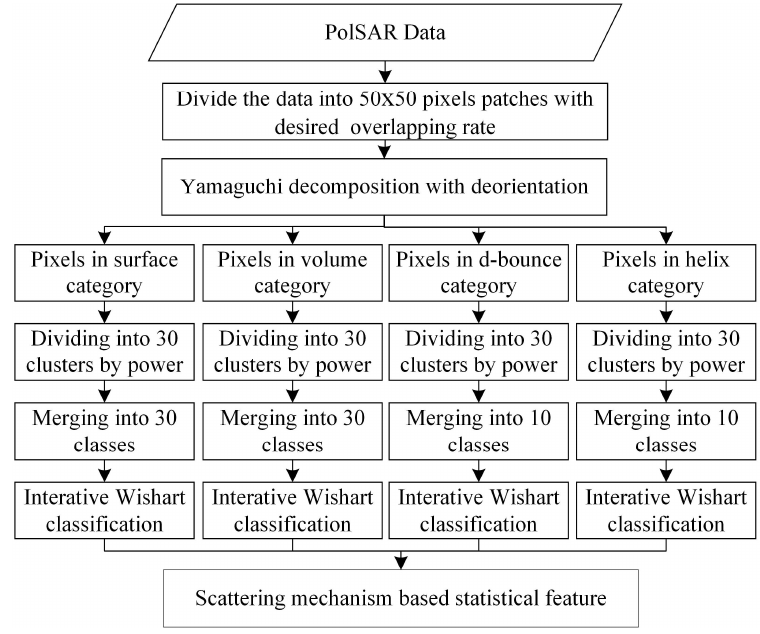
Figure 3. The applied mid-level polarization feature (scattering mechanism based statistical feature) representation algorithm.